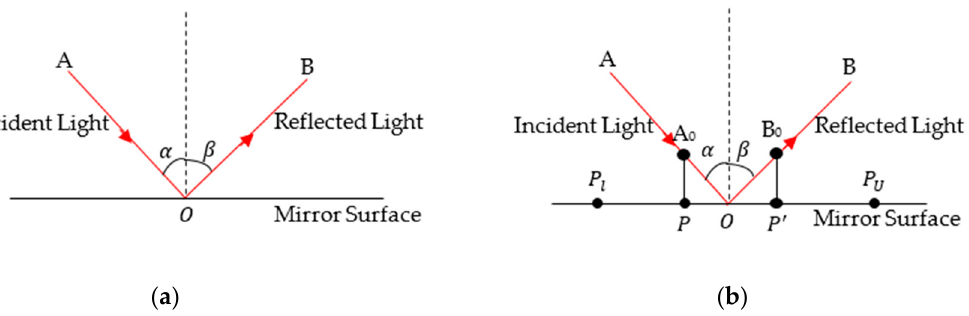
Figure 2. Specular reflection learning illustration; ( a ) The phenomenon of specular reflection and ( b ) The model of specular reflection.